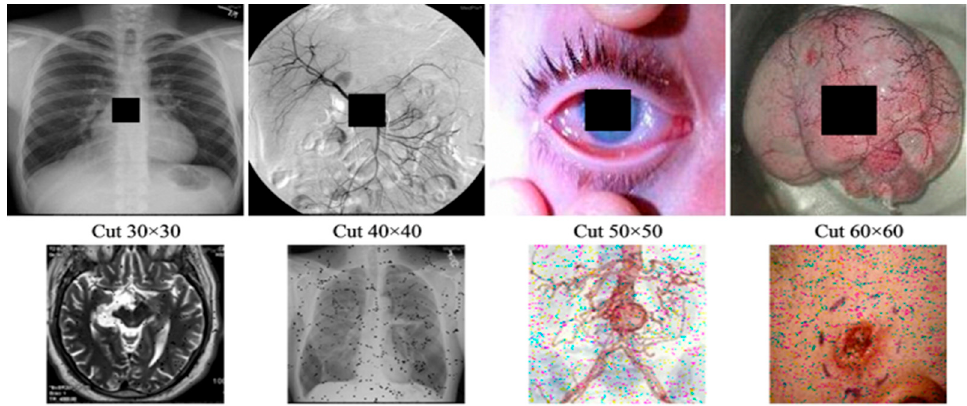
Figure 7. Stego and extracted images under noise of various densities. The first row shows the stego images with added Salt and Pepper noise and their corresponding extracted versions in the second row.